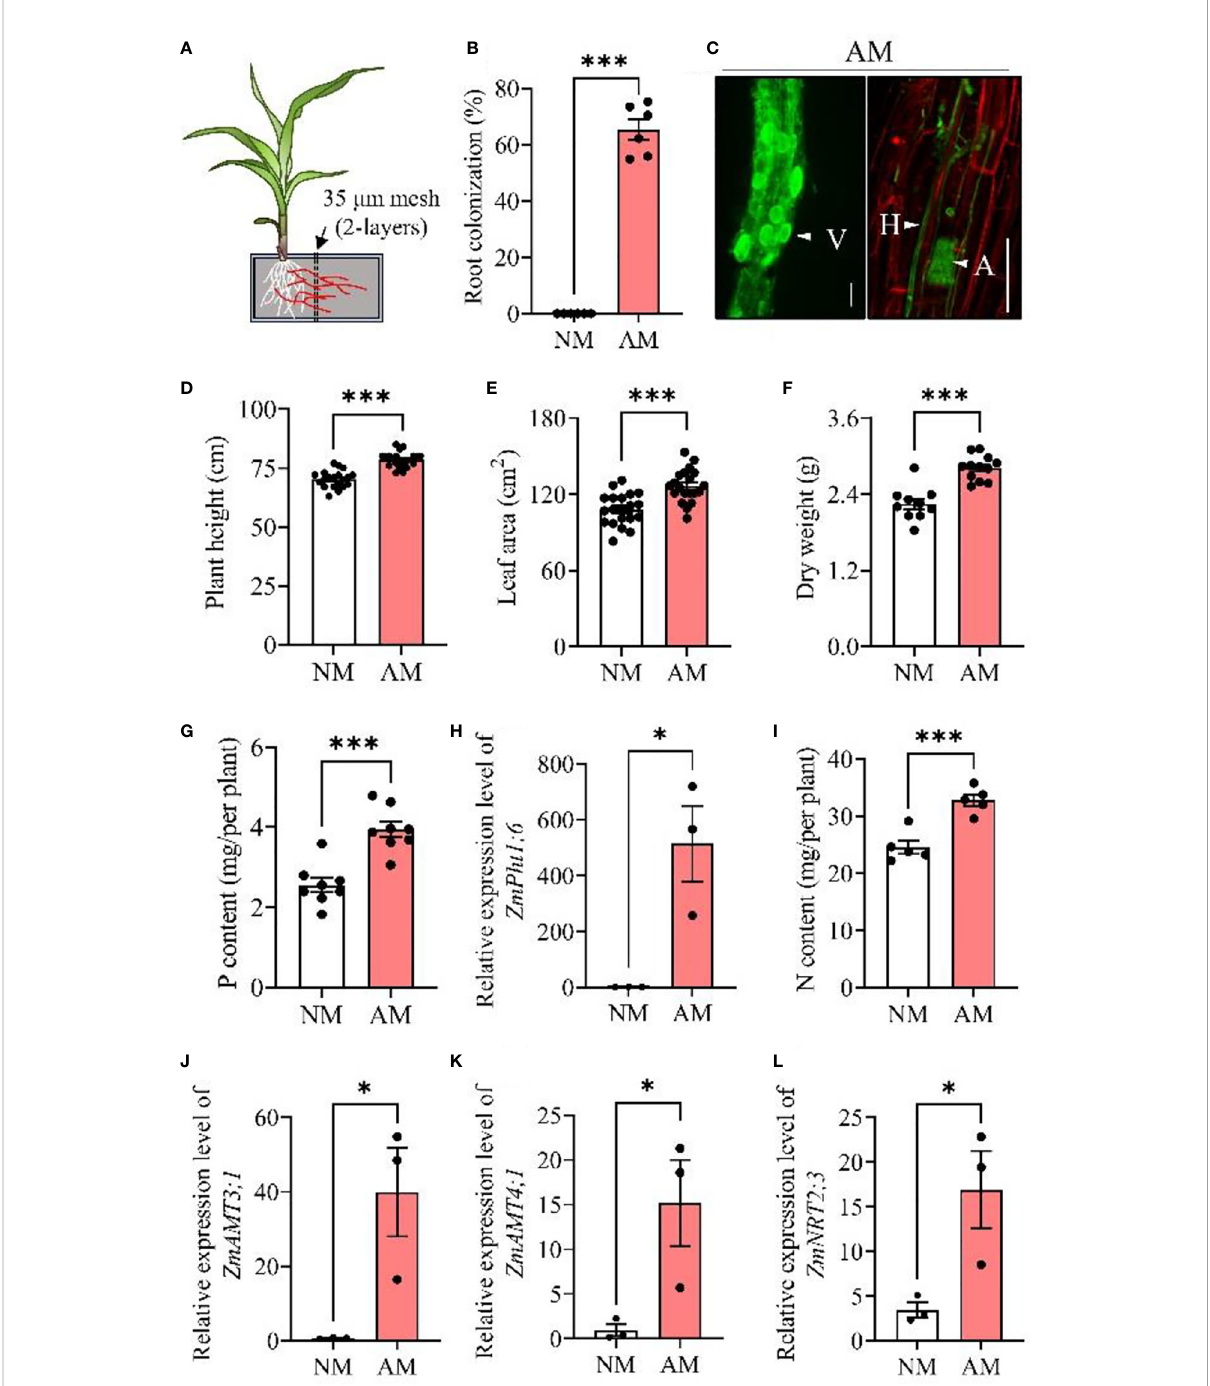
FIGURE 1 Mycorrhizal symbiosis promotes the growth and nutrient uptake of maize plants. Maize plants were inoculated with Rhizophagus irregularis ( Rir ) and cultivated in self-designed boxes (A) . Five weeks post- Rir inoculation, maize plant roots were harvested for the measurement of mycorrhizal root colonization rate (B) and mycorrhizal observation by wheat germ agglutinin (WGA) fl uorescence staining (C) (bar scale: 25 m m). Plant height (D) , leaf area (E) , and dry weight (F) were measured, followed by the analysis of phosphorus content (G) , ZmPht1;6 (a mycorrhizal symbiosis marker gene in maize) expression (H) , nitrogen content (I) and N transporter gene expressions (J – L) . For analysis of root colonization, n = 6; plant height and leaf area, n = 20; dry weight, n = 10; nitrogen content, n = 5; phosphorus content, n = 8; expression of ZmPht1;6 and N transporter genes, n = 3. Data are means ± SE. Asterisks at the top of the bars indicate statistical signi fi cance (Student ’ s t-test, * P < 0.05; *** P < 0.001; ns, no signi fi cance). NM, non-mycorrhizal maize plants; AM, arbuscular mycorrhizal maize